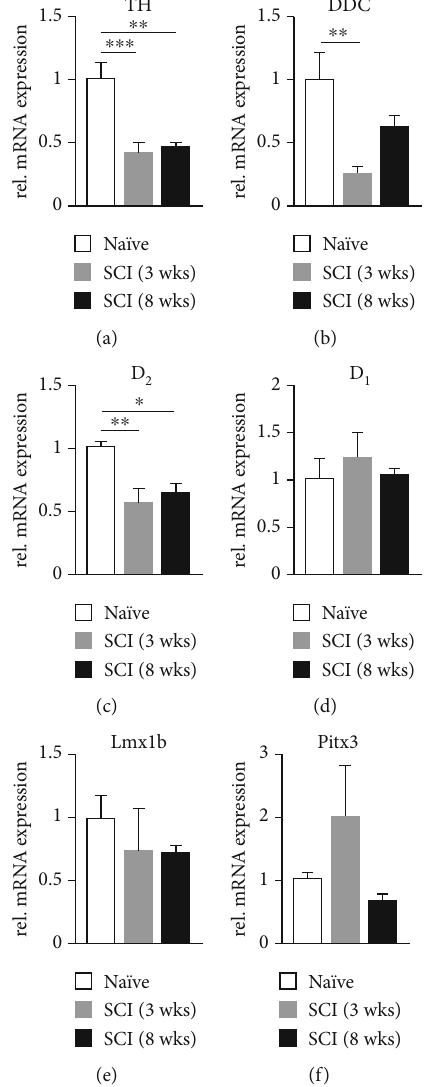
Figure 3: Changes of DA-related transcripts in the spinal cord caudal to the injury site. In the L1 spinal segment, mRNA levels of TH (a) and D (c) are downregulated 3 weeks after SCI, and this change is sustained out to 8 weeks. However, mRNA levels of DDC (b) are decreased 3 2 weeks after SCI but steadily recover at the 8-week timepoint. No changes were observed in D ∗ p < 0 : 05 , ∗∗ p < 0 : 01 , ∗∗∗ p < 0 : 001